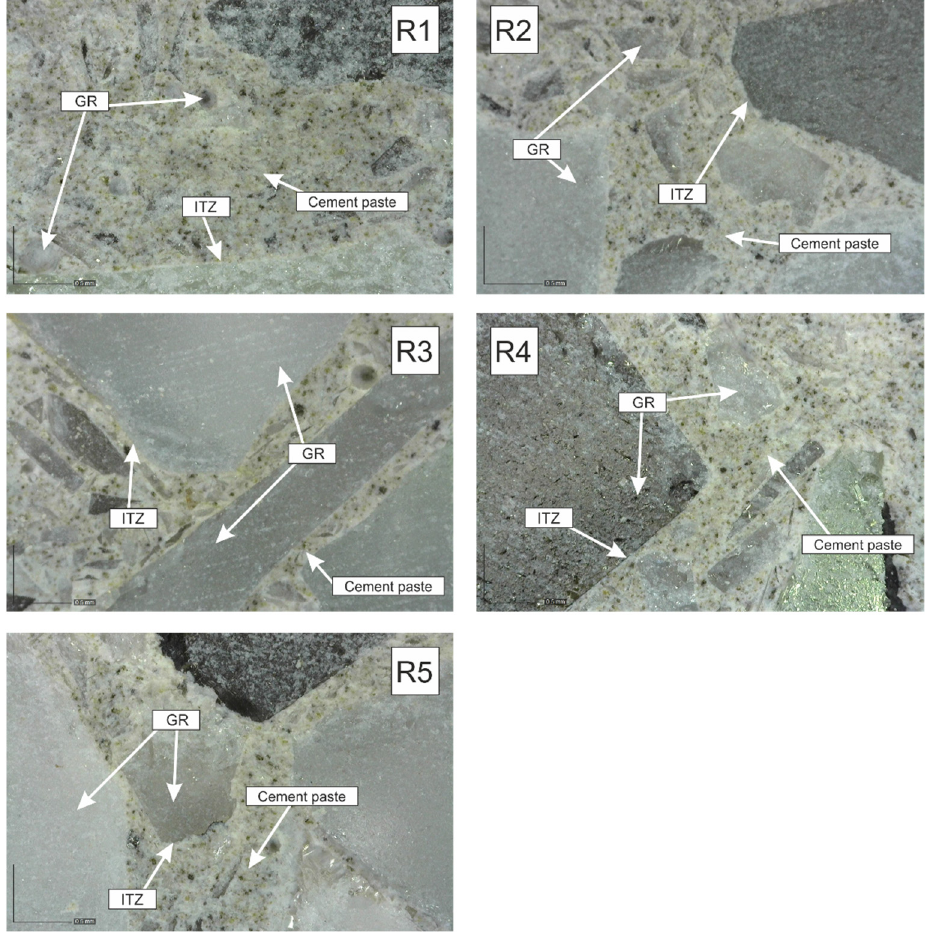
Figure 15. Image analysis of the cement composite samples according to recipes R1–R5; magnified 102×.